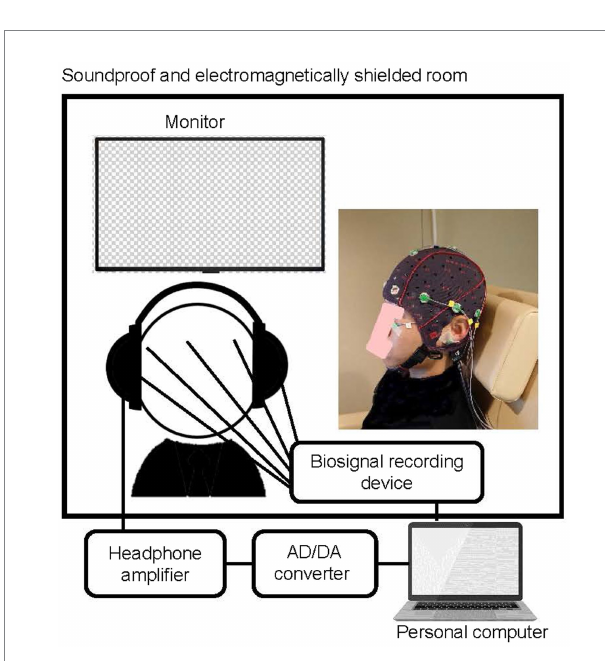
FIGURE 5 Experimental configuration of the physiological experiment.